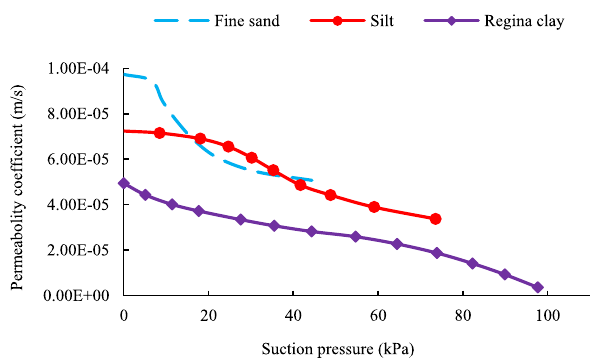
Table 4 Comparison of the results among Hankel shape function (18 elements) and Lagrange shape function (18 and 4900 elements) for the fourth problem